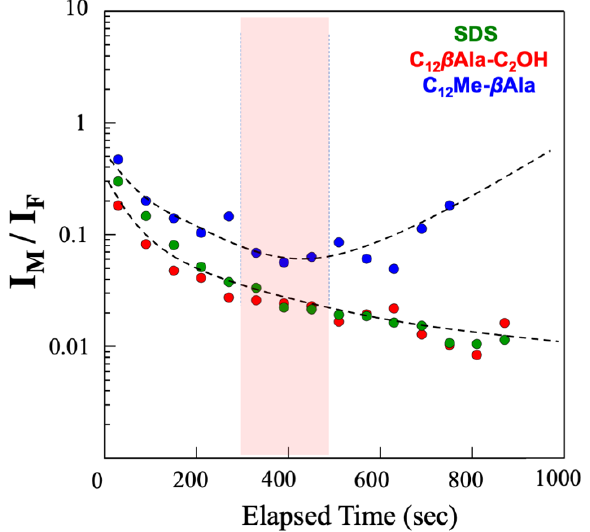
Figure 18. Ratio of scattering intensity between micelle and foam ( I M / I F ), obtained for SDS (green), C 12 – EtOH – β Ala (red), and C 12 – Me – β Ala (blue). Time domain at 300 – 480 s is indicated in red. Broken lines are guides for the eye.